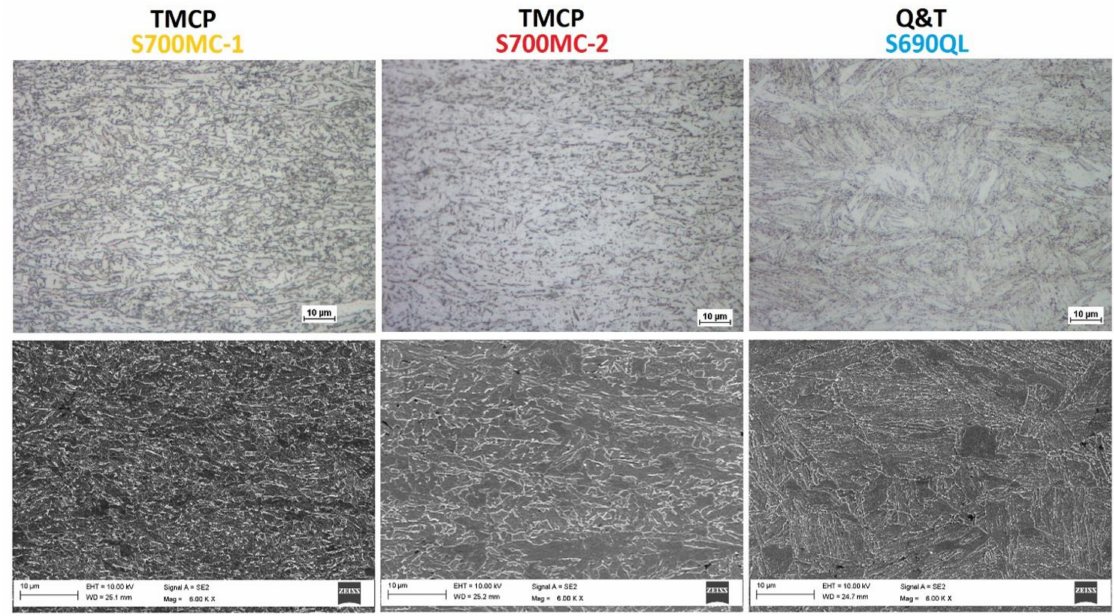
Figure 1. Optical (above) and SEM (below) micrographs of microstructures of the three base materials. The microstructures of TMCP (MC) steels are fairly similar between each other, consisting of fine ferritic grains with small amount of second phase constituents at the grain boundaries. Deformation from the rolling can be seen as elongated grains. Base material of Q&T steel consists mainly of tempered